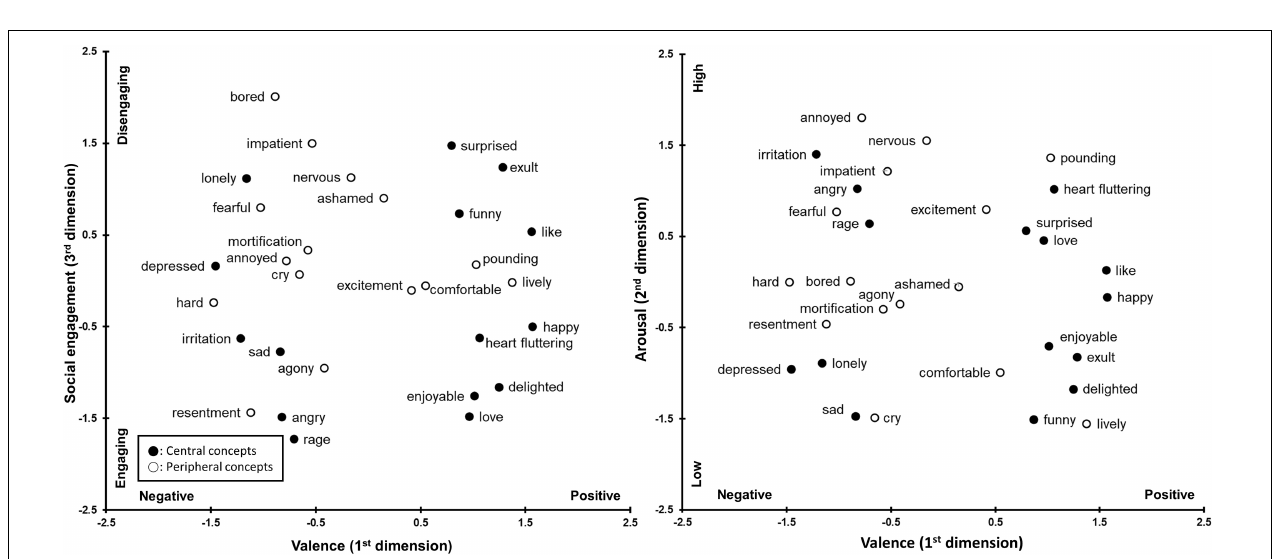
FIGURE 2 | The three-dimensional structure of central and peripheral concepts in